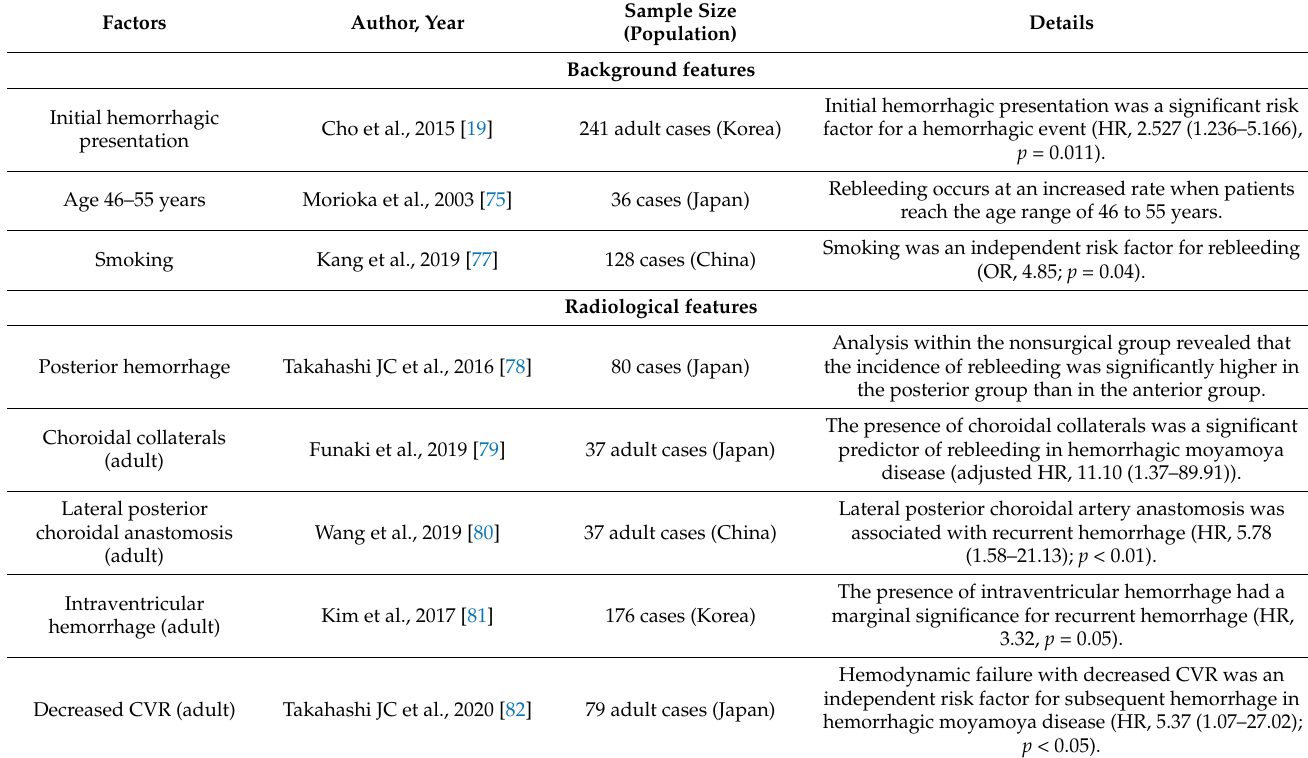
Table 5. Factors associated with recurrence of hemorrhagic symptoms in hemorrhagic onset moyamoya